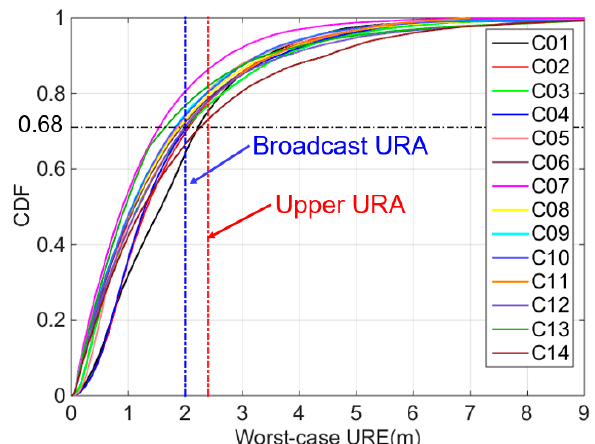
Figure 5. Cumulative distribution functions of the worst-case UREs for each BDS satellite (The blue dashed line indicates the broadcast URA of 2 m, the red dashed line indicates the upper URA of 2.4 m, and the black dashed line indicates the 68% overbound).